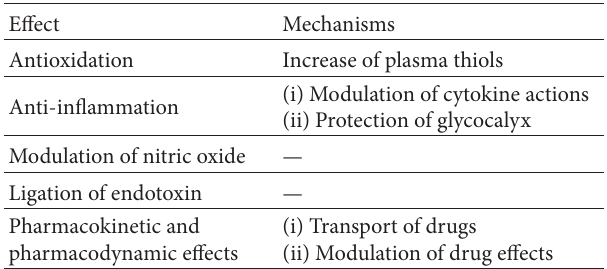
Table 1: Effects of human albumin infusion unrelated to oncotic pressure [6, 17,